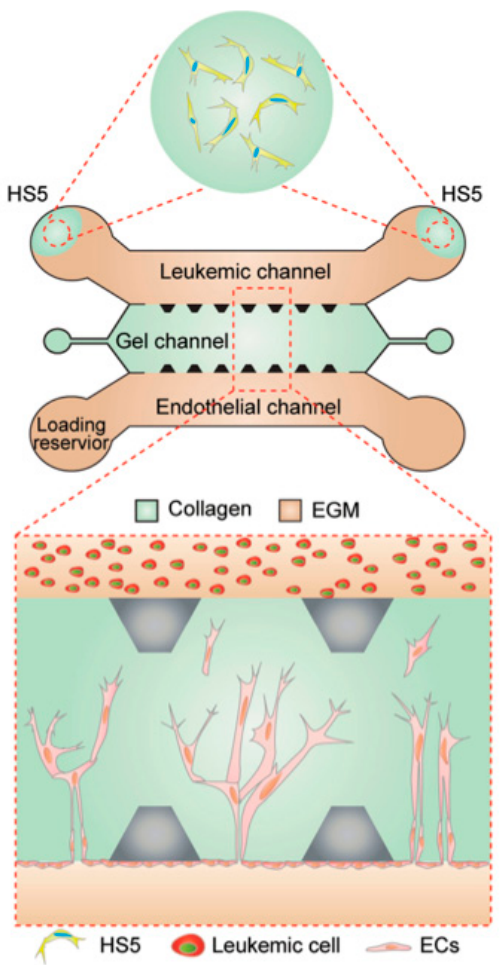
Figure 4. Schematic of an angiogenic microfluidic platform with three parallel channels, the central channel of which contains collagen gel. This acts as a barrier between the ECs and leukemic cell channels. In assays using stromal cells, cells from the bone marrow stomal cell line HS5 were injected into the leukemic cell channel prior to loading leukemic cells. The zoomed in illustration depicts the endothelial to leukemic directionality of angiogenesis seen in the model. EGM = EC Growth Medium. Adapted with permission from Zheng et al. [169].